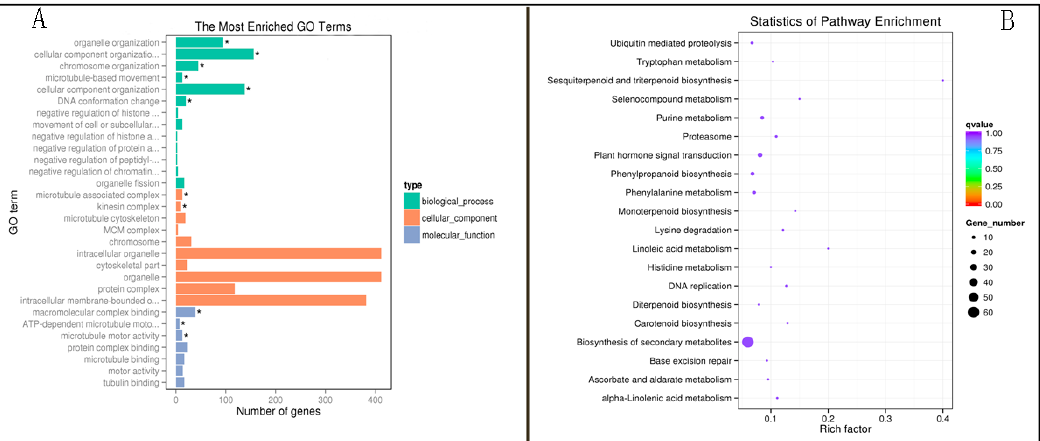
Figure 7. Gene ontology (GO) classifications of differentially expressed genes (DEGs) ( A ) Enriched GO terms for the 1603 genes (* p < 0.05). ( B ) Enriched KEGG pathways for the 1603 genes.